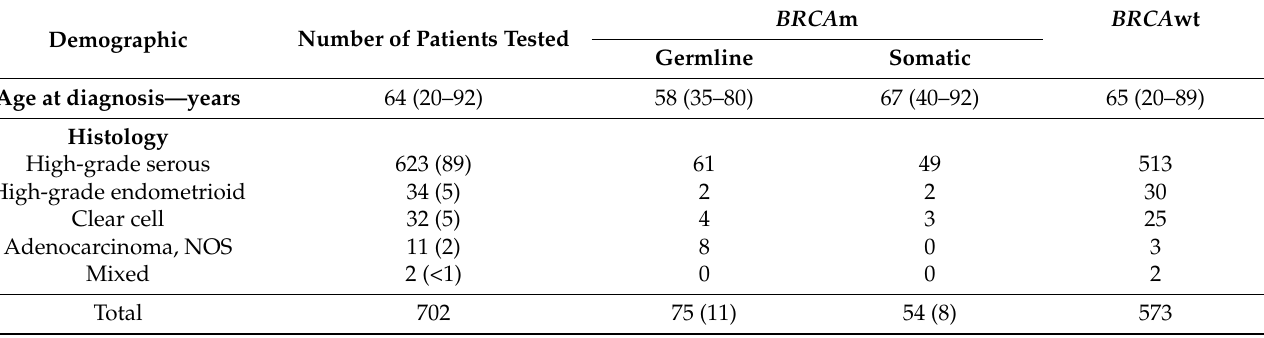
Table 1. Demographic data for patients that underwent BRCA1/2 testing. Data are presented as mean (range) or number (percentage; the denominator being the ‘Total number of patients tested’).